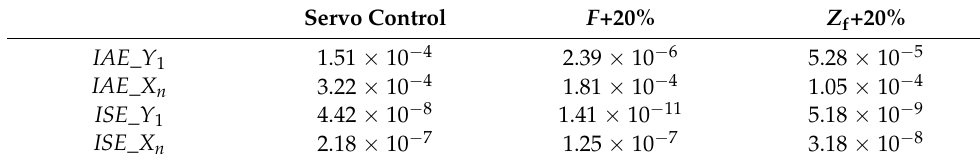
Table 7. Error index of PID in Case